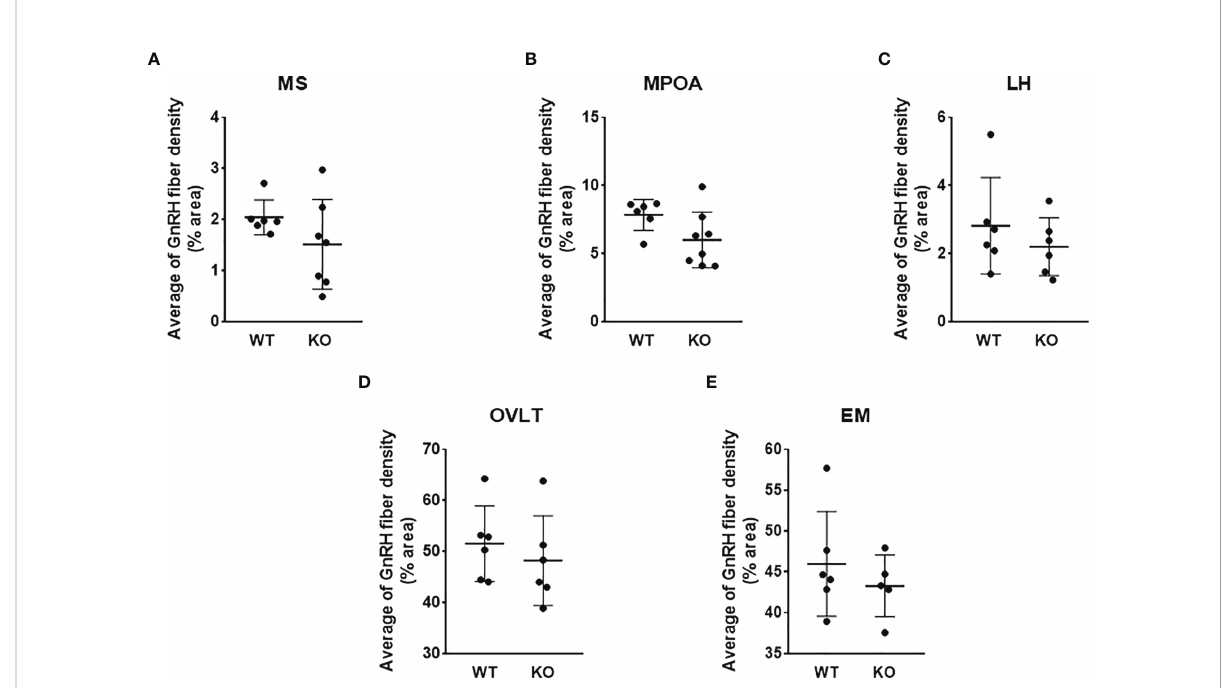
FIGURE 4 GnRH-ir in wild-type and PACAP KO female mice. GnRH-ir data in regions of medial septum (MS), medial preoptic area (MPOA), lateral hypothalamus (LH), organum vasculosum of lamina terminalis (OVLT), and eminentia mediana (EM) obtained from WT and PACAP KO mice are presented in panels A – E , respectively. Experiments were performed in female mice in estrus phase. Data are presented as mean ± SD, n = 6 – 8.